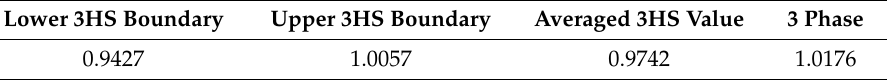
Table 14. Three-phase thermal conductivity approximations—cement system D.